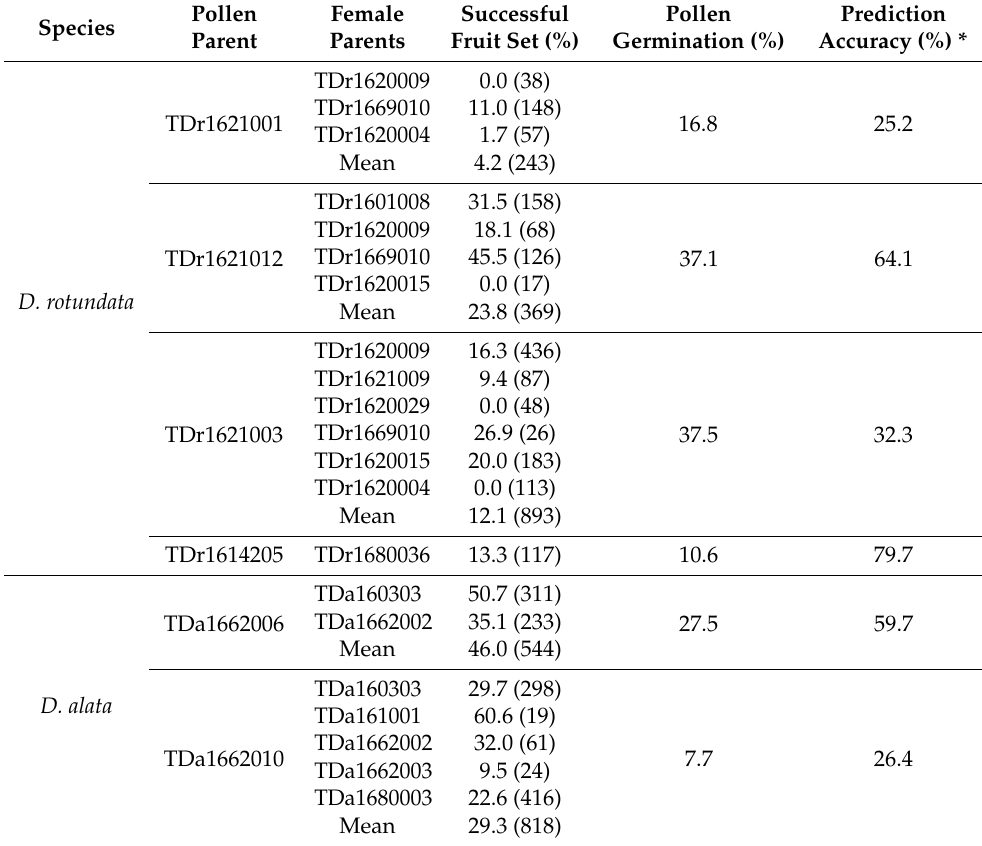
Table 4. Hand pollination success vs. in vitro pollen